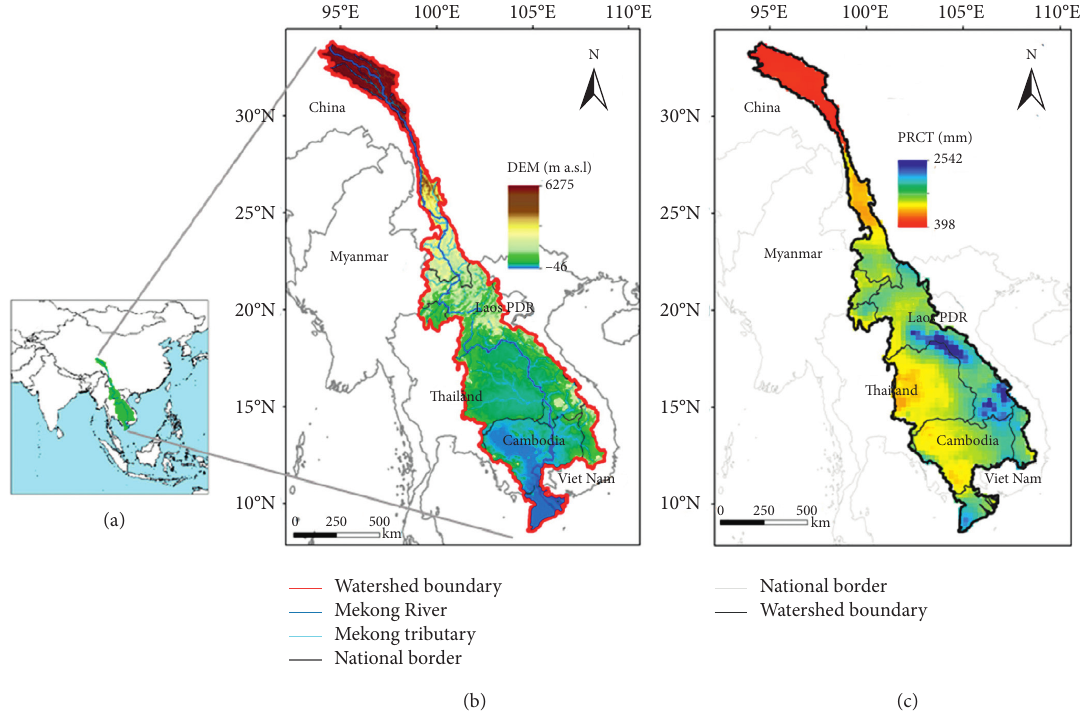
Figure 1: The location (a), elevation (b), and annual average precipitation (c) of the Mekong